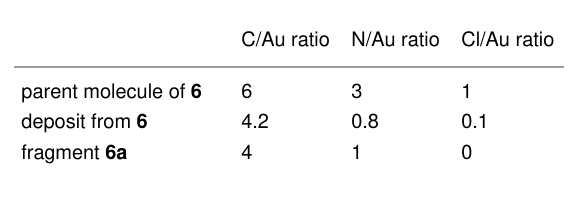
Table 3: Ratios between the atomic percentages of elements present in the precursor molecule of 6 , the deposit from 6 and a putative frag- ment 6a (see Figure